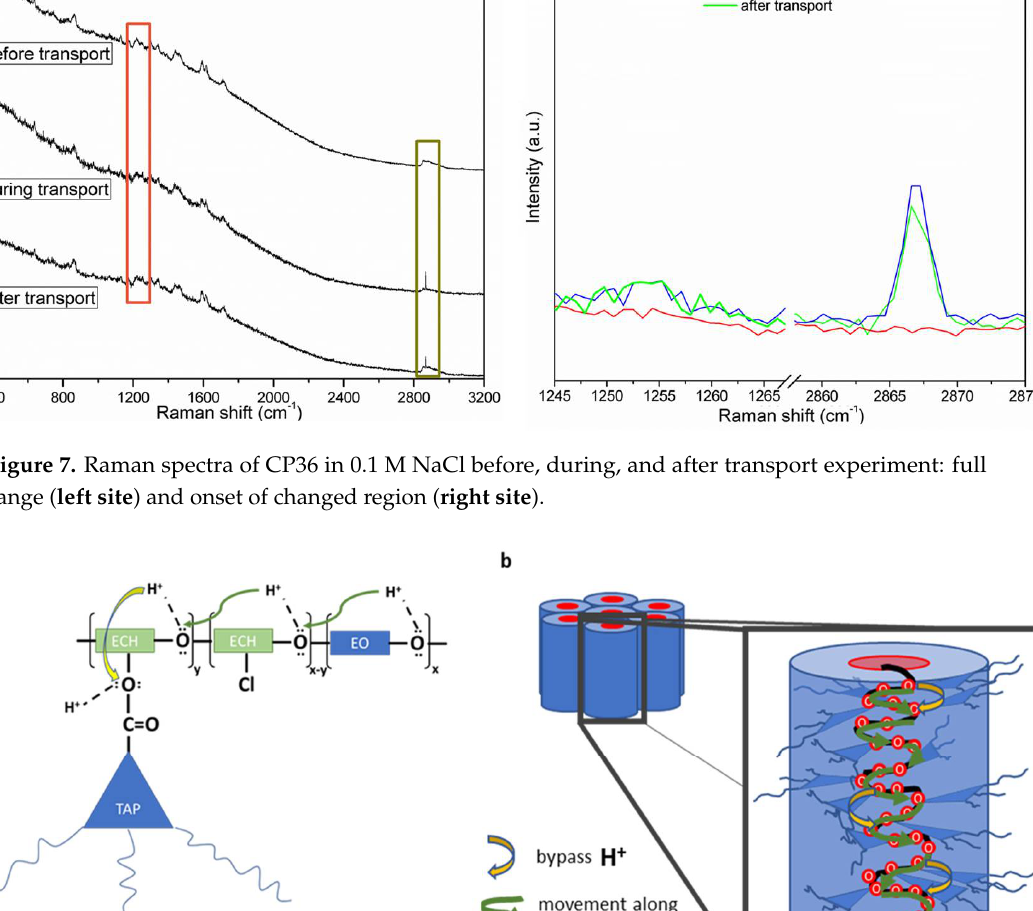
Figure 8. Schematic representation of cation movement inside the ionic channel: ( a ) hopping proton along polymeric chain (ECH—epichlorohydrin and EO—ethylene oxide) and ( b ) ion movement through single column.